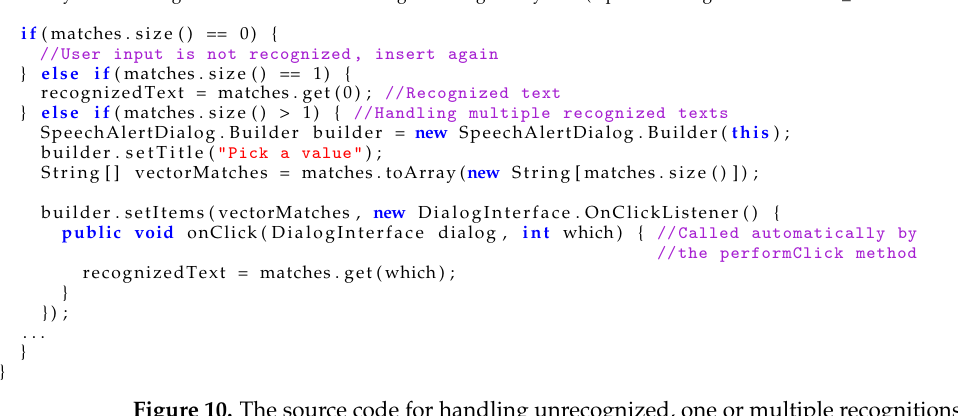
Figure 10. The source code for handling unrecognized, one or multiple